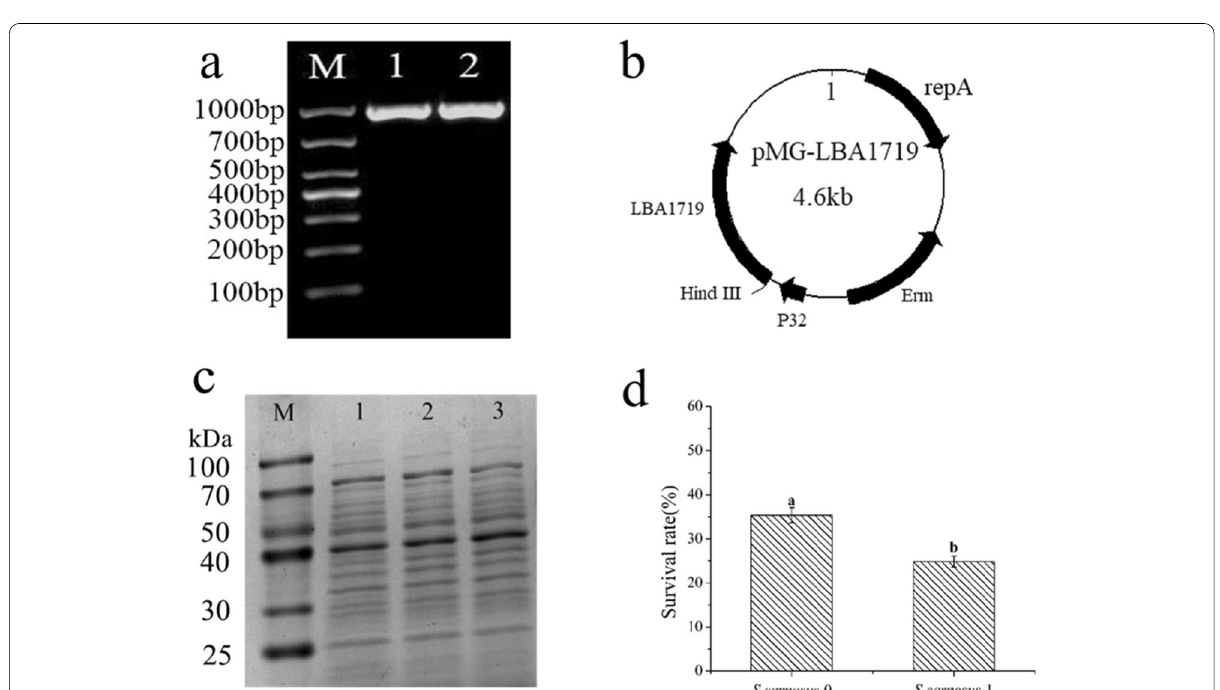
Fig. 1 Overexpression of LBA 1719 and lyophilization-survival rates for S. carnosus. a Electrophoresis results for the PCR products of LBA 1719. b Maps of recombinant expression plasmid pMG-LBA1719. (M, marker DL1000; lanes 1–2, products of full length LBA 1719). c Expression of recombinant S. carnosus UGPase in transformants (M, protein markers; lane 1, S. carnosus- 0 UGPase; lanes 2–3, S. carnosus -1 UGPase. d Lyophilisation-survival rates for S. carnosus -0 and S. carnosus